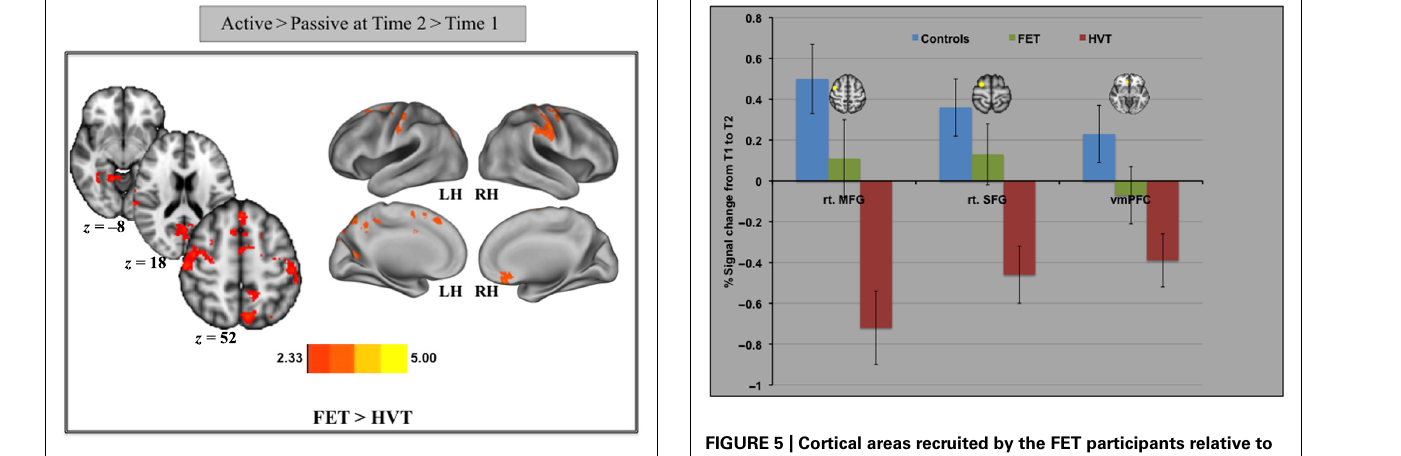
FIGURE 4 | Change in percent signal change from pre- to post-training in the cortical areas found in the contrast of Control > Training for all three groups.